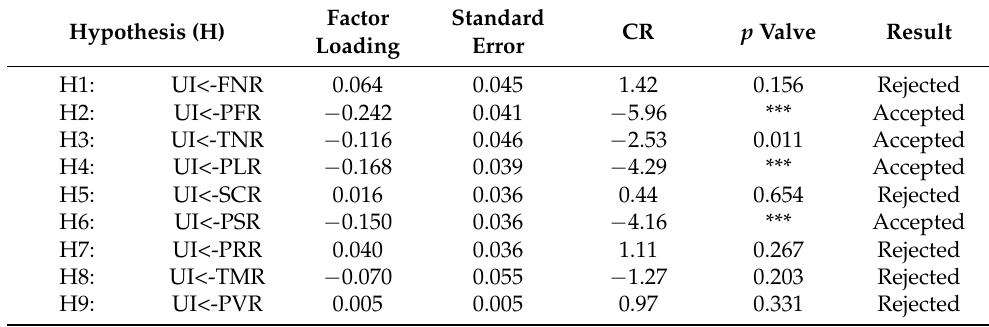
Table 6. Results of hypothesis